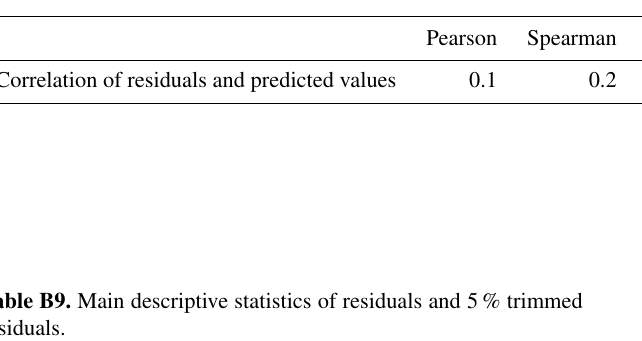
Table B8. Pearson, Spearman, and R 2 correlation coefficients be- tween residuals and predicted values.